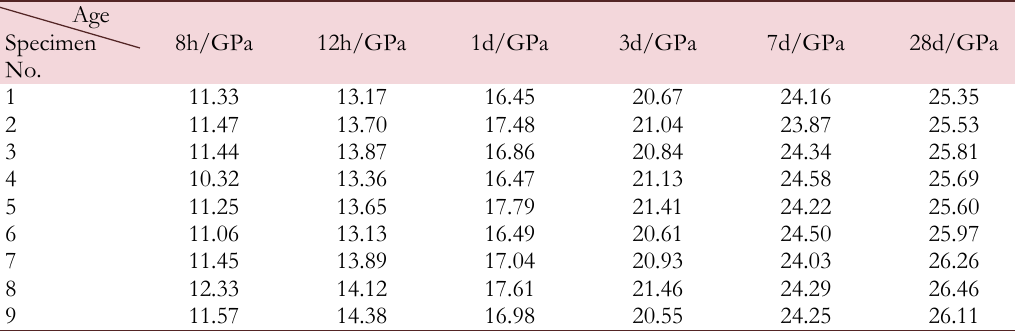
Table 7: Elasticity modulus of shotcrete added with the new liquid accelerator Take a log-scale for time, get the elasticity modulus-time regression curve of shotcrete with the traditional accelerator and with the new liquid accelerator, as shown in Fig.4.